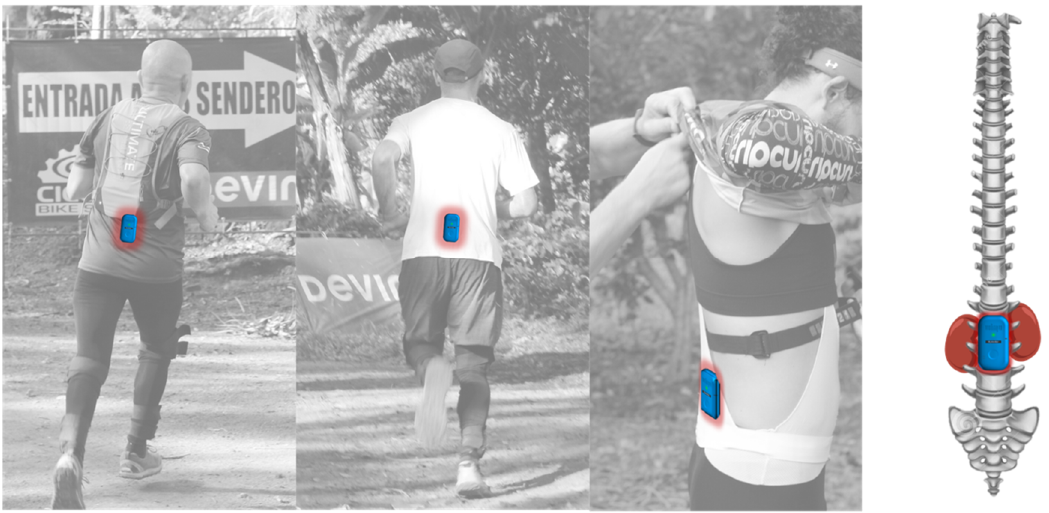
Figure 1. Inertial measurement unit attachment at runner´s lower back (L1–L3).